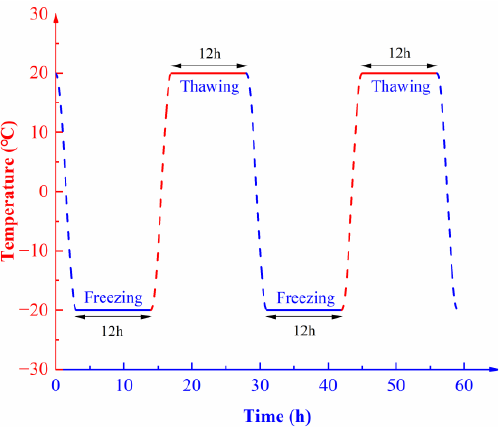
Figure 4. F-T scheme for the muddy siltstone specimen.